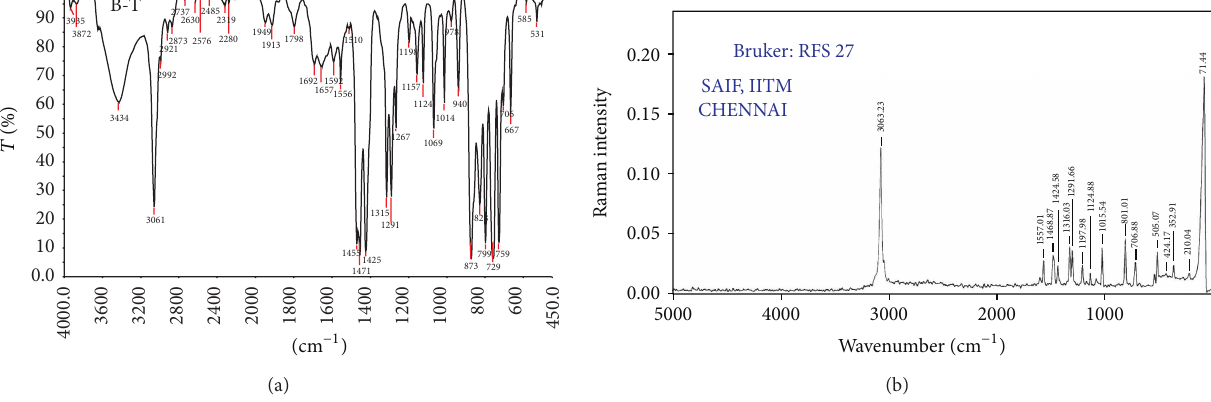
Figure 3: Experimental FT-IR and FT-Raman spectrum of benzothiazole.